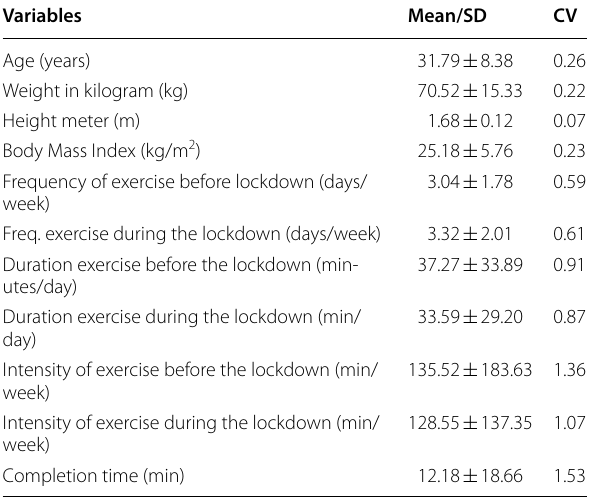
Table 1 Physical Characteristics of the Subjects (values are in mean and SD)